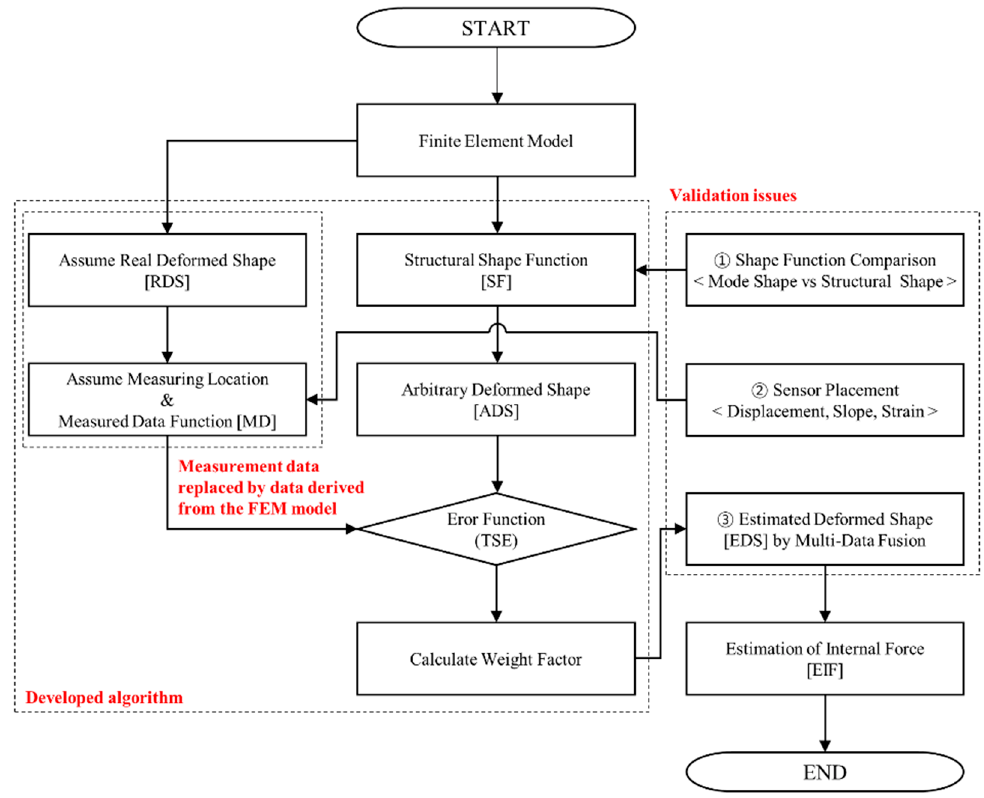
Figure 2. Validation procedure through finite element method (FEM) model considering three issues.